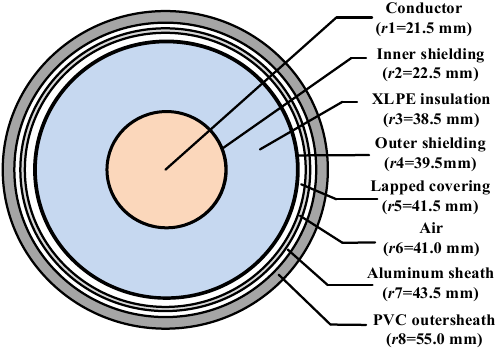
Figure 1. Equivalent transient thermal circuit model of a single-core XLPE cable. Configuration of the cable. r x ( x = 1~8) is the corresponding outer radius of each layer.